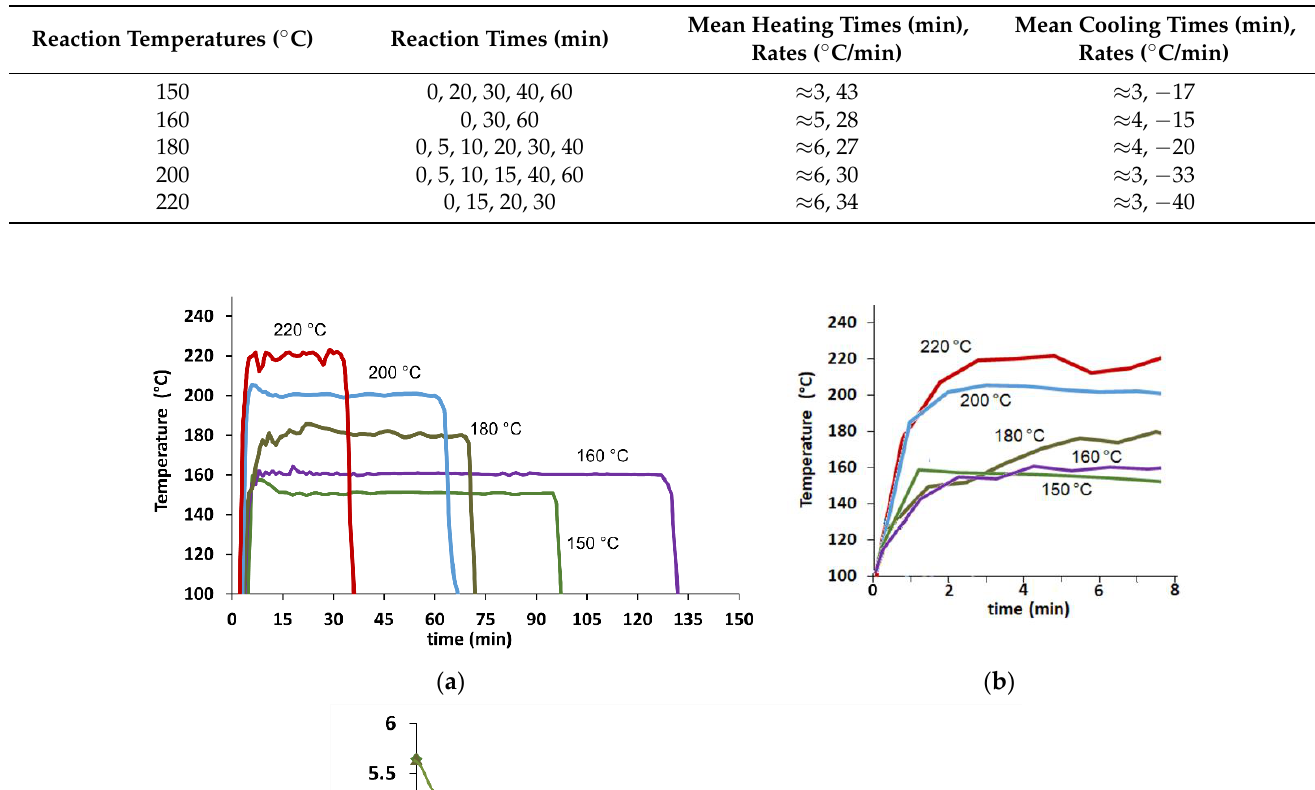
Table 1. Characterization of reaction temperature trajectories.